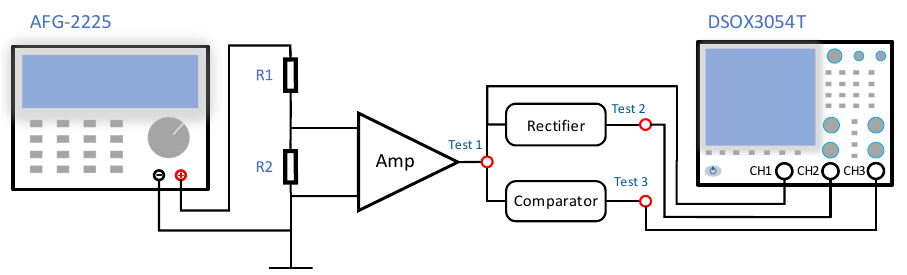
Figure 12. Schematic of envelope signal and shaping signal test.